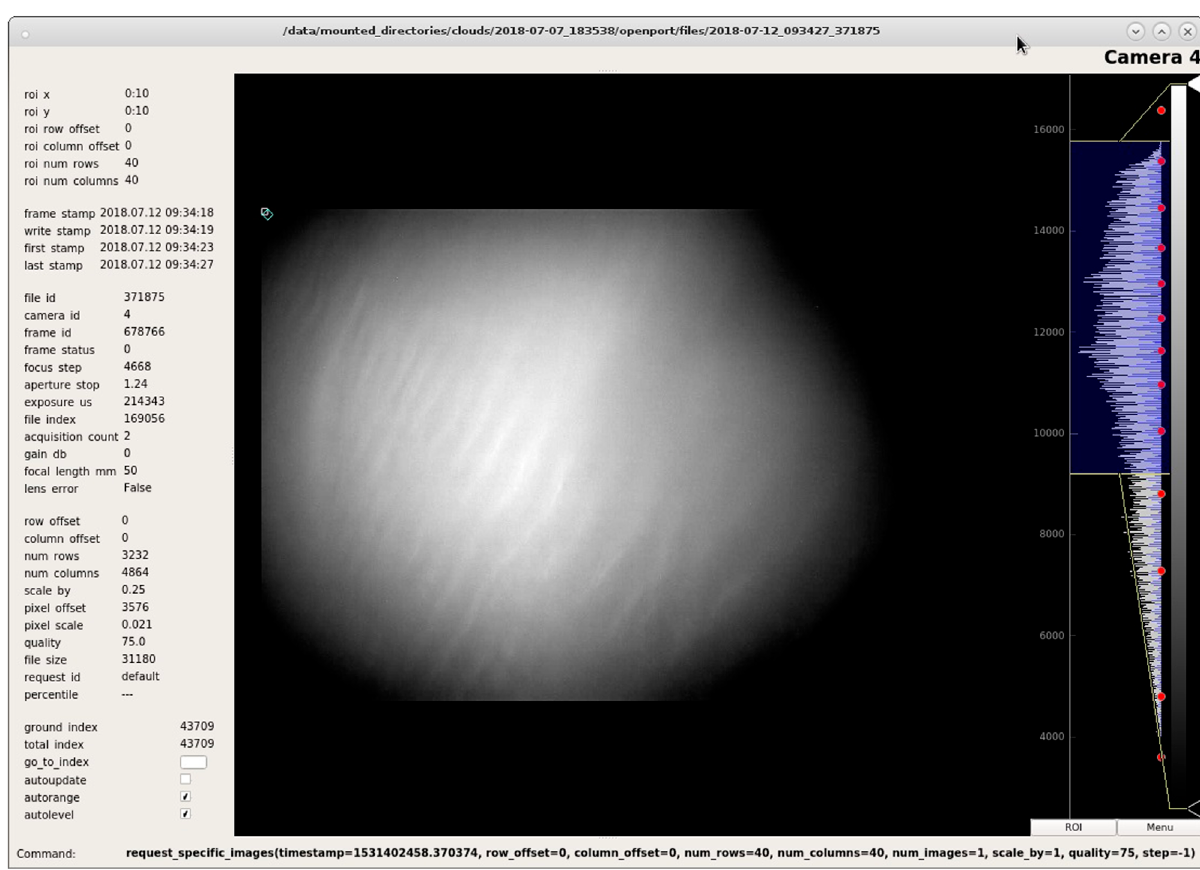
bright stripes oriented diagonally within the image. The left column displays metadata, including exposure time, aperture stop, file id, and focus step. The metadata also informs the viewer of the level of downsampling of the image and the time stamp of the image. In the upper left corner of the image within the GUI is a selection tool, whichcanbedraggedandre-sized.Thetextbelowtheimagechanges as the user adjusts the selection and gives a command argument to request the selected region of the image. To the right a histogram of the image allows a viewer to change the display grey scale range live and see image